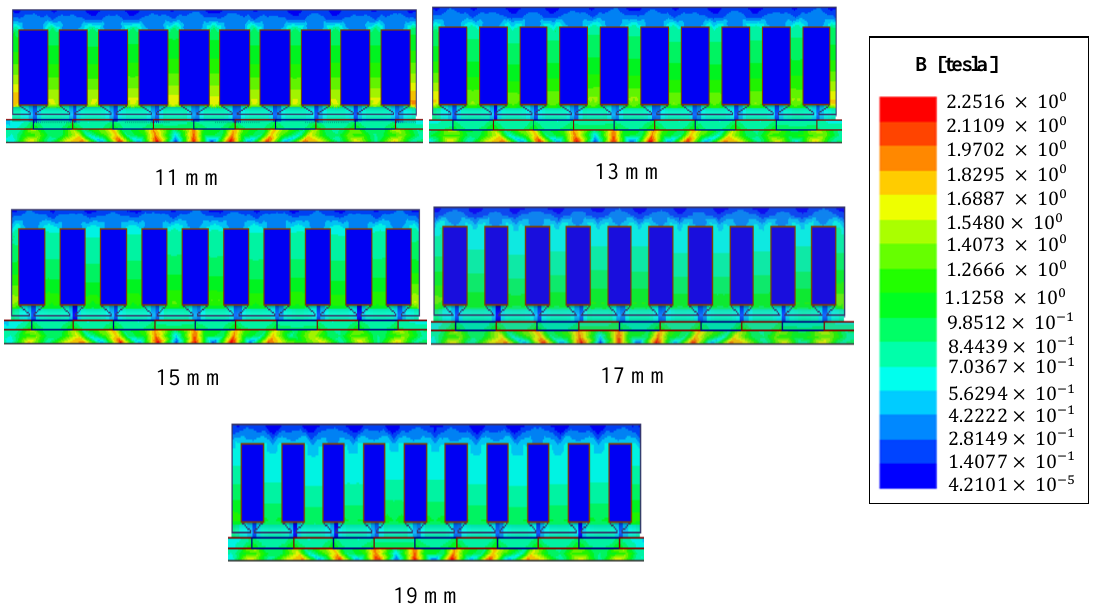
Figure 21. Influences of T w Variation on Flux density at Stator of TPMLM-NS.